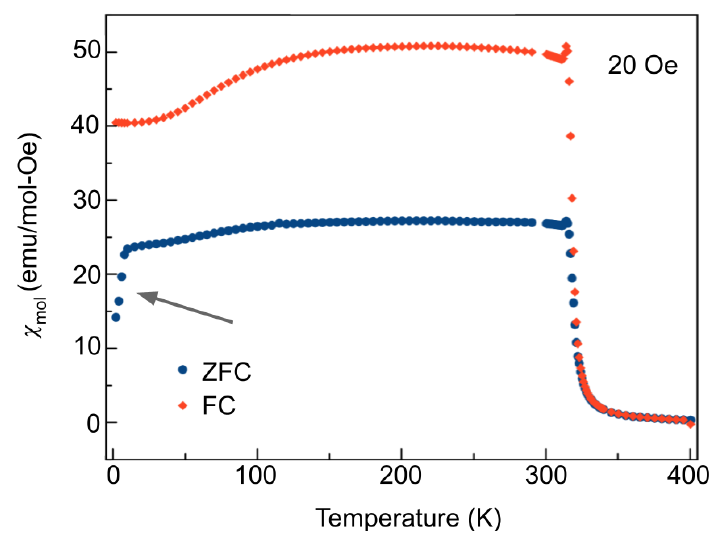
Figure 4. Magnetic susceptibility per mol of Co 8 Zn 8 Mn 4 after zero-field cooling (ZFC) and field cooling from 400 K in a magnetic field of 20 Oe. The bifurcation behaviour of the ZFC and FC curves at 7 K results from the path-dependent behaviour of the susceptibility (as indicated by the arrow in the ZFC curve), which is indicative of a spin glass